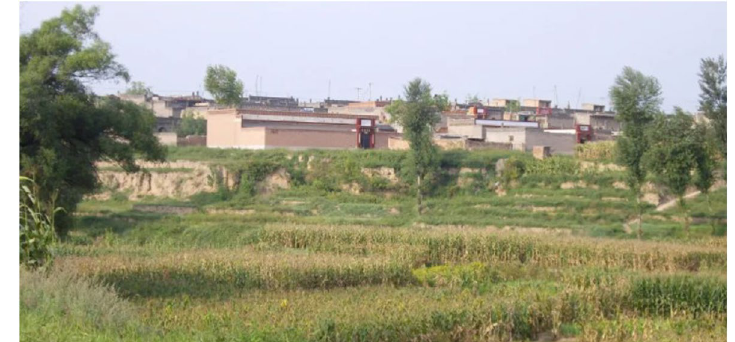
Fig. 13 New buildings with urban sprawl and dry valleys (Source: the author)